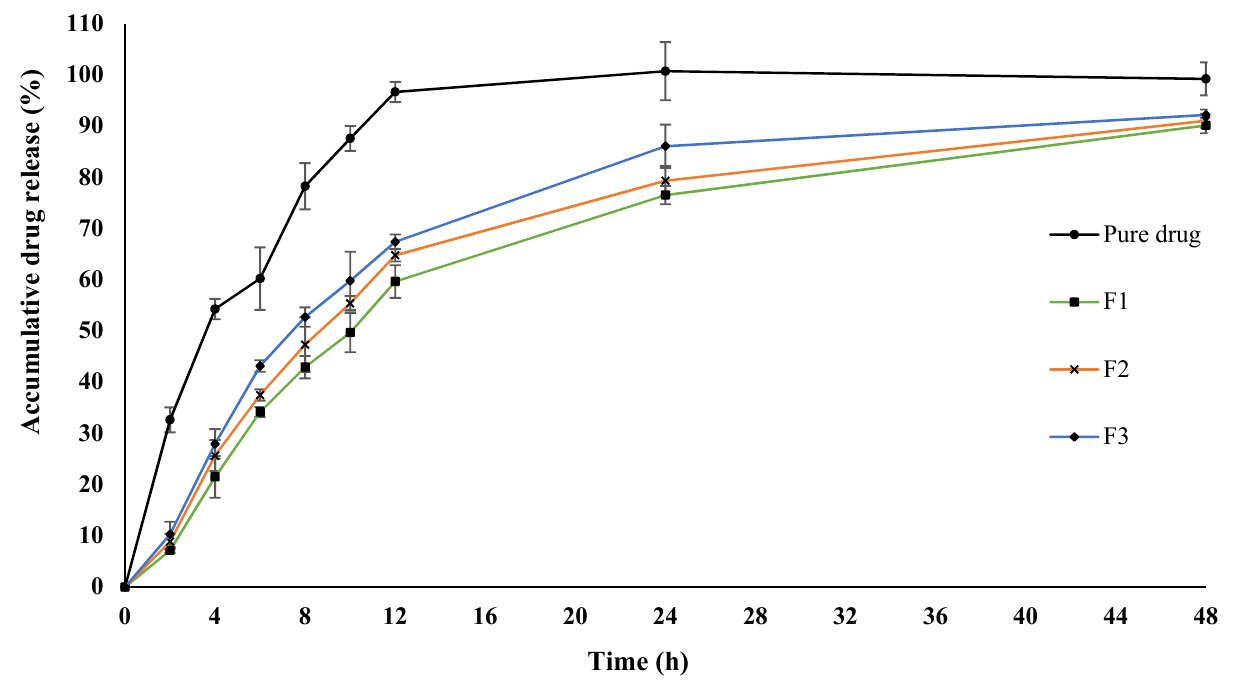
Figure 2. The in vitro drug release profile of curcumin-loaded SEDDS formulations.